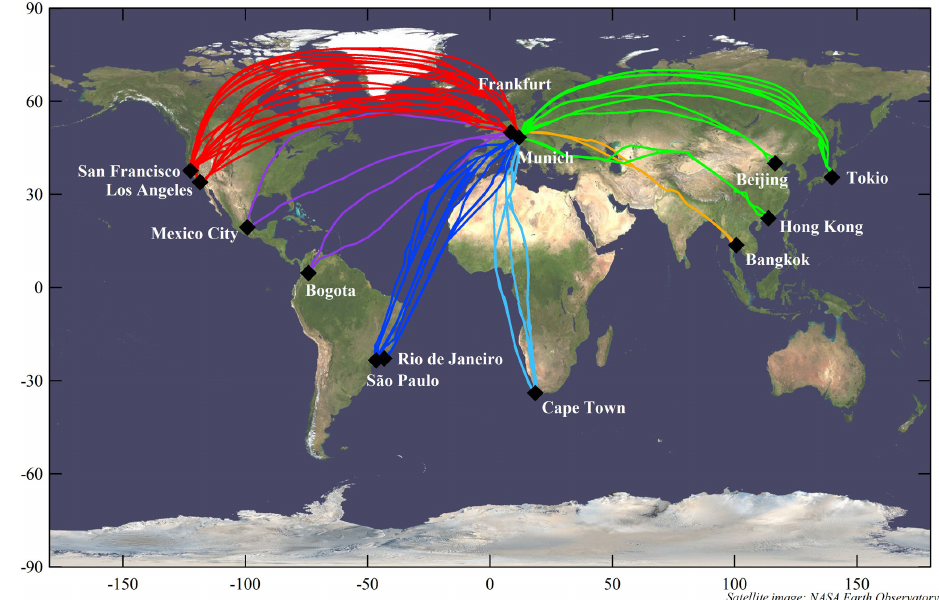
Figure 1. Tracks of the CARIBIC flights made between April 2014 and February 2016 (CARIBIC flights no. 468-536). Mercury data for these flights were obtained by post-flight processing of the Tekran raw signal (Slemr et al.,